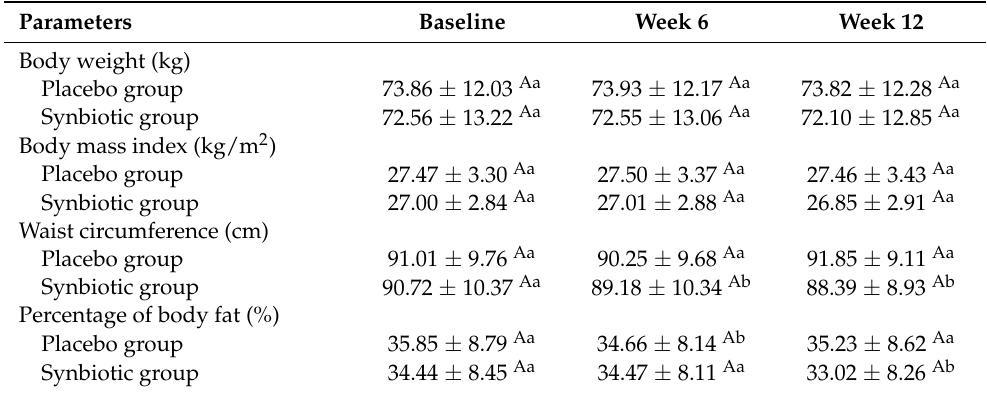
Table 2. Effect of 12-week synbiotic intervention on body composition in overweight and obese